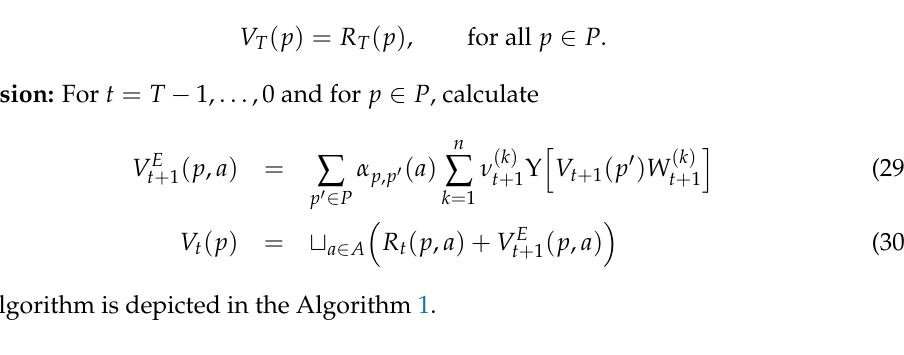
Algorithm 1: Value Function